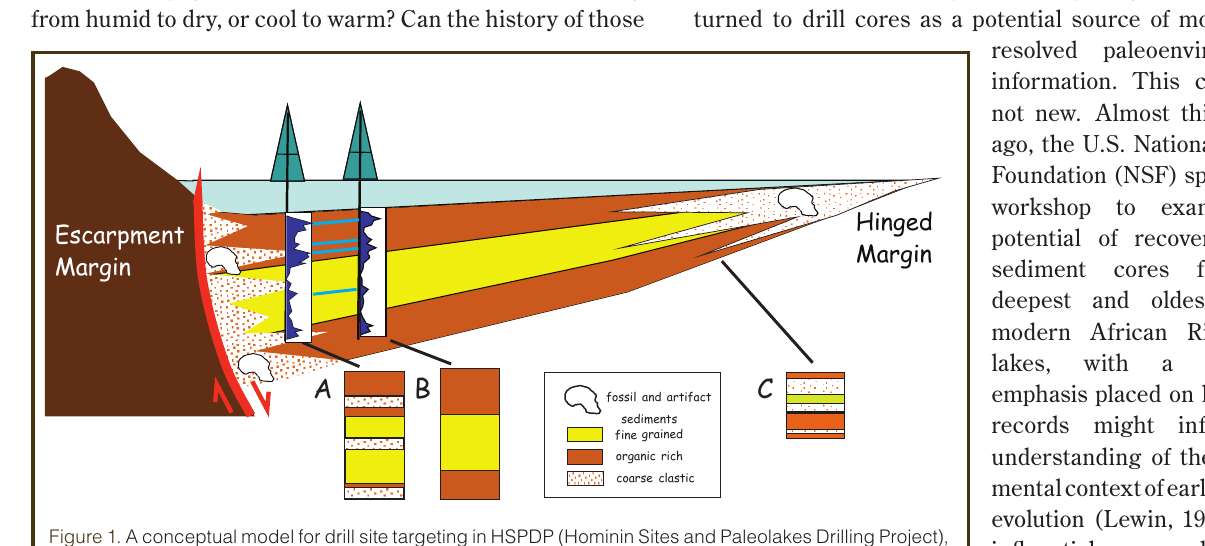
Figure 1. A conceptual model for drill site targeting in HSPDP (Hominin Sites and Paleolakes Drilling Project), using a half-graben rift basin depositional model. Note that a lake is shown in the diagrammatic cross section, although for the current phase of drilling we are targeting paleolake deposits where drilling from a barge can be avoided. The primary target (Drill Site B) would be far enough from the paleoshoreline to avoid most coarse clastic facies (pattern), with a relatively thick and highly resolved stratigraphic record. These types of offshore (fine-grained, organic rich) sediments (shown as yellow and brown solid colors) are most likely to yield the continuous paleoclimatic records useful for addressing current questions about hominin evolution/climate interactions. In contrast, a hinged margin site (C), even though potentially in close proximity to fossil and artifact localities, will yield a thinner and more discontinuous record, and one in which high stand lake deposits are over-represented. A more proximal target on the escarpment margin (A) will yield a dominantly coarse-grained stratigraphic record that is also less desirable for paleoclimate studies, although it may provide a useful secondary target for correlation into the hominin-bearing outcrops and/or records of tectonic uplift affecting the